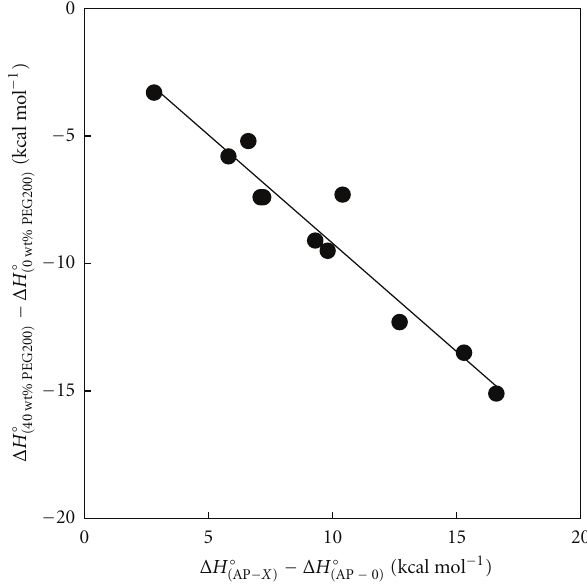
Figure 5: Plots of the molecular crowding e ff ects on enthalpy − change for G-quadruplex formation Δ H ◦ (40 wt% PEG200) Δ H ◦ versus abasic site e ff ects on enthalpy change for (0 wt% PEG200) − Δ H ◦ at 0 wt% PEG200 G-quadruplex formation Δ H ◦ (AP − X ) (AP − 0) ( X indicates the numbers from 1 to 11) in a bu ff er of 100mM NaCl, 50mM Tris-HCl (pH 7.0), and 1mM Na 2 EDTA at 0 wt% (0molL − 1 ) and 40wt% (2molL − 1 )